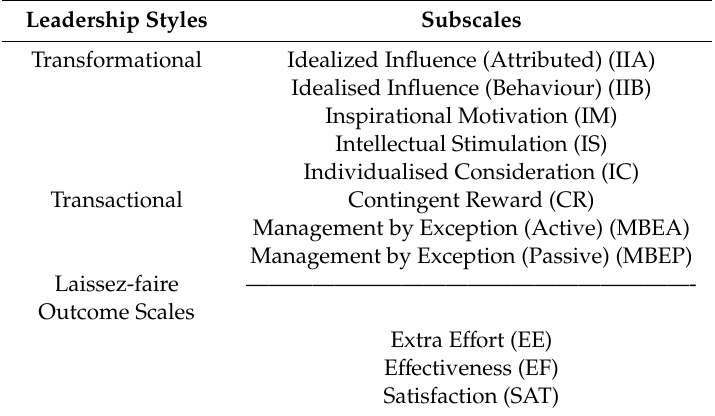
Table 2. Leadership style Subscales used in the Multifactor Leadership Questionnaire